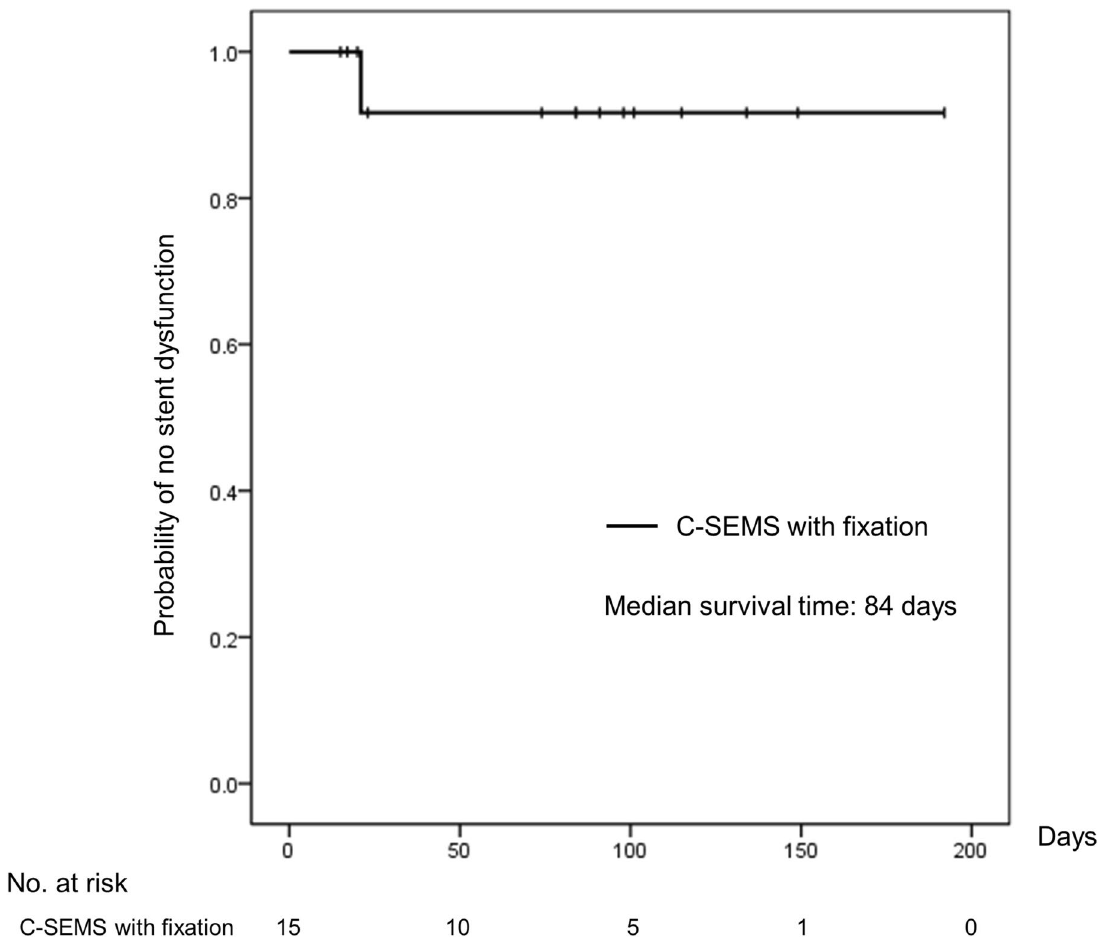
Figure 1. Cumulative stent patency was analyzed by using the Kaplan–Meier method. The median survival time of the study cohort was 84